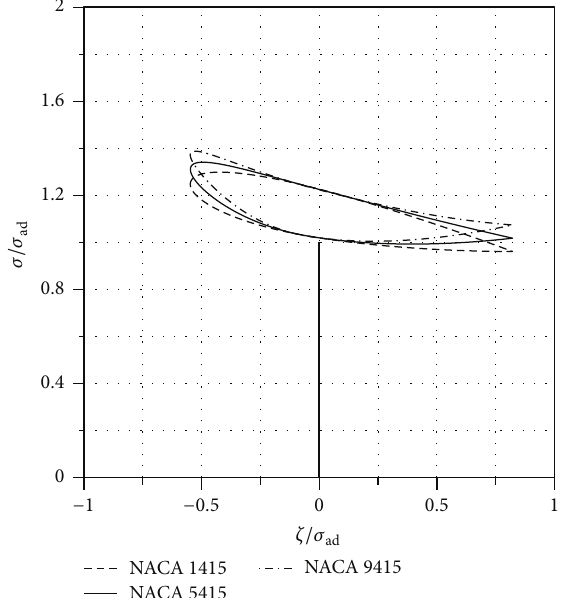
Figure 3: Profiles employed to investigate the effects of the duct cross section thickness.